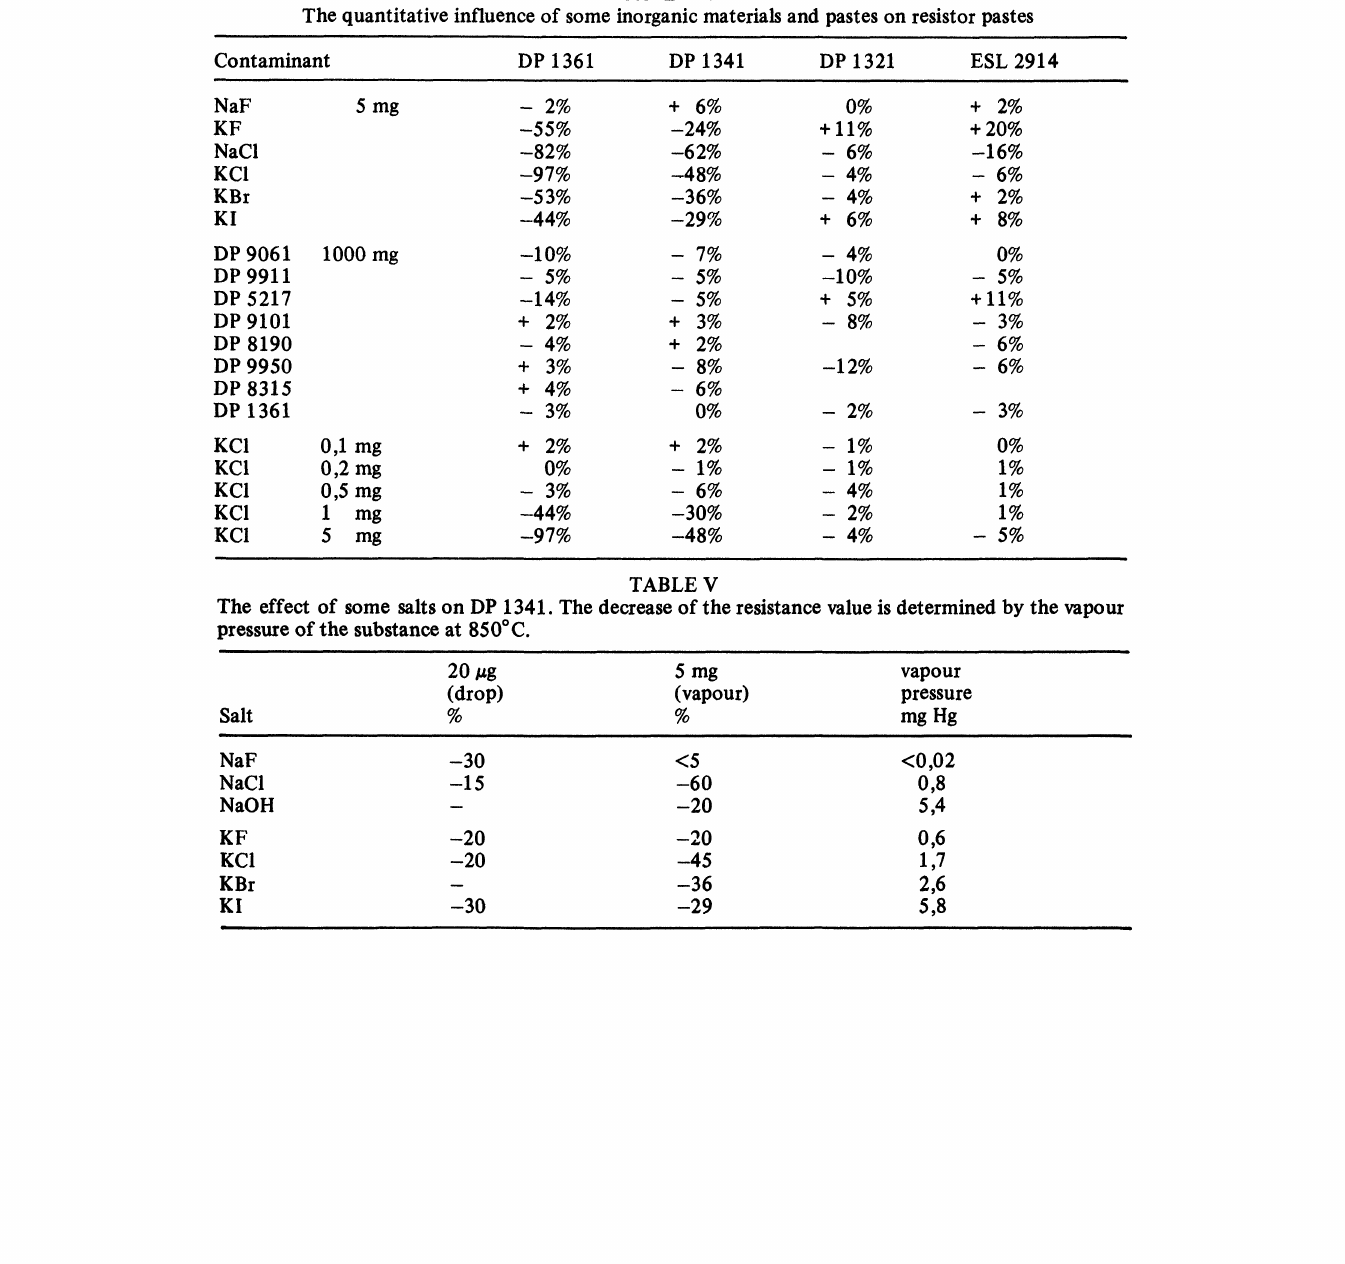
TABLE V The effect of some salts on DP 1341. The decrease of the resistance value is determined by the vapour pressure of the substance at 850